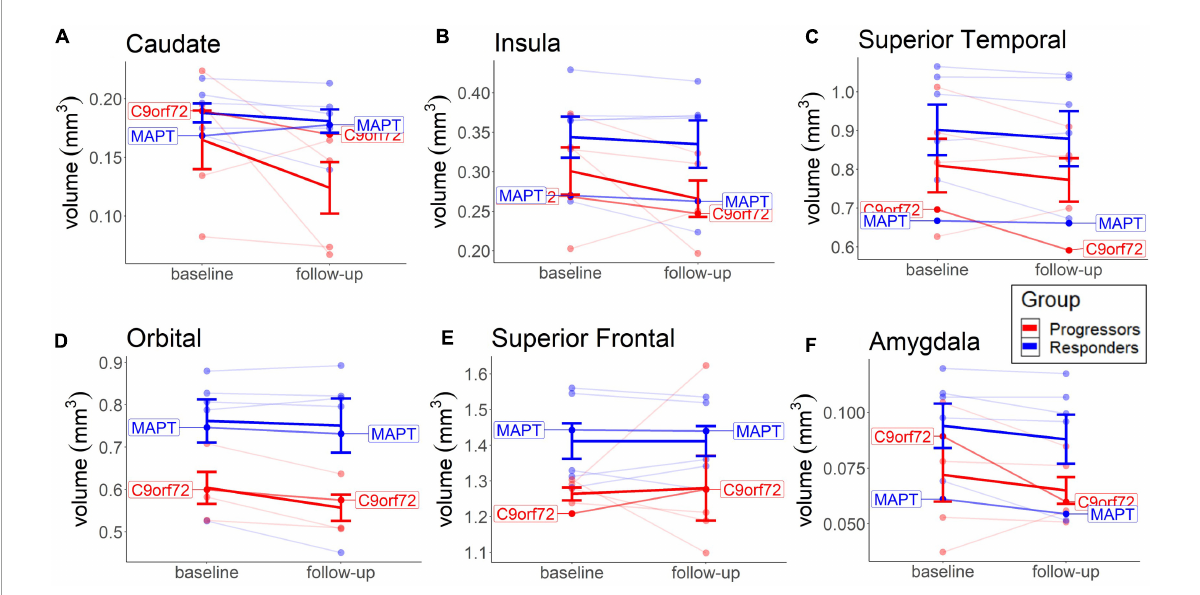
FIGURE5 Baseline and long-term MRI brain volume change in each group. Depicted are the Caudate (A) , Insula (B) , Orbital (C) , and Superior Frontal region (D) , because of more visible group differences, compared to other brain areas. Thick lines reflect group means. Both patients with the identified mutation are